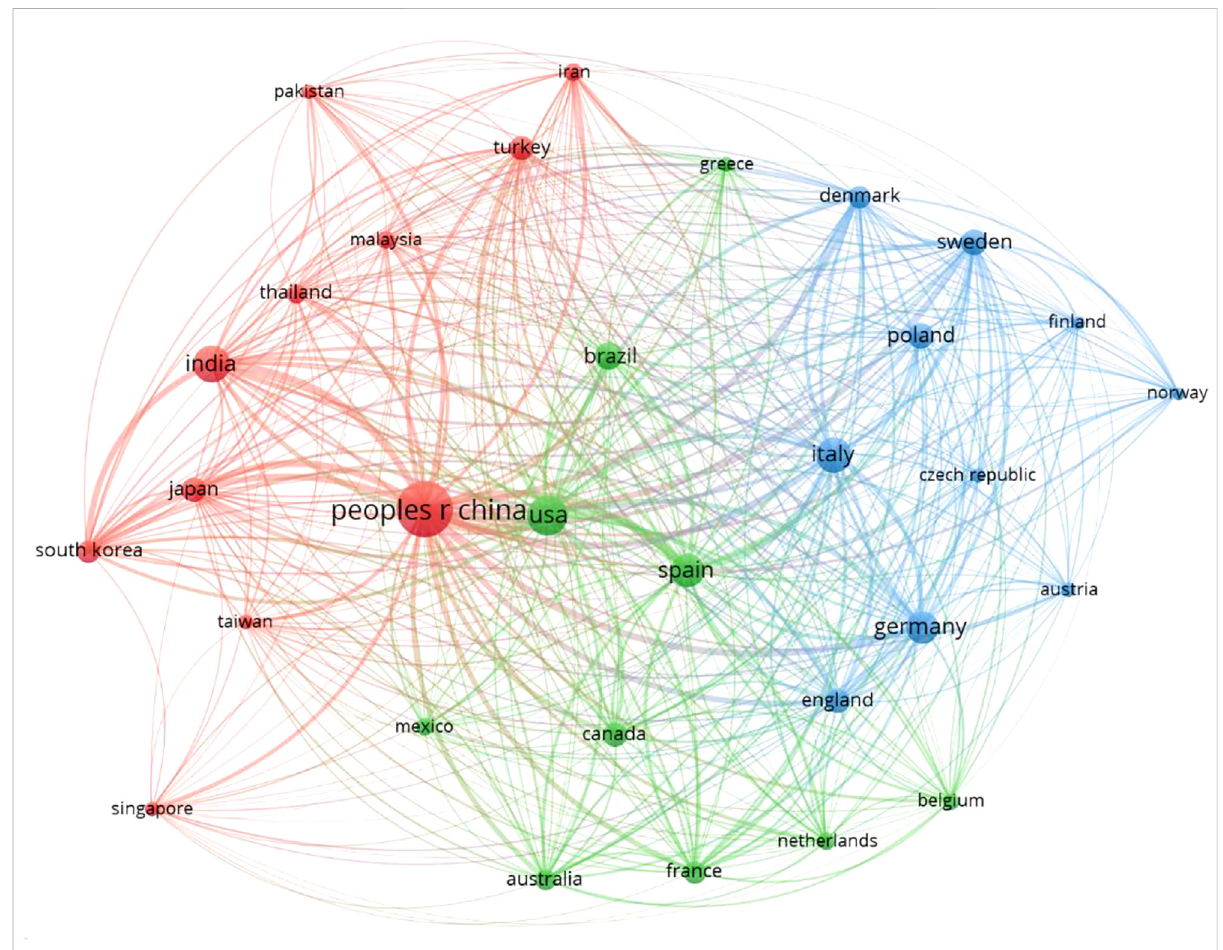
FIGURE 4 Currently active countries on nanotechnology-based biogas production on the basis of the number of